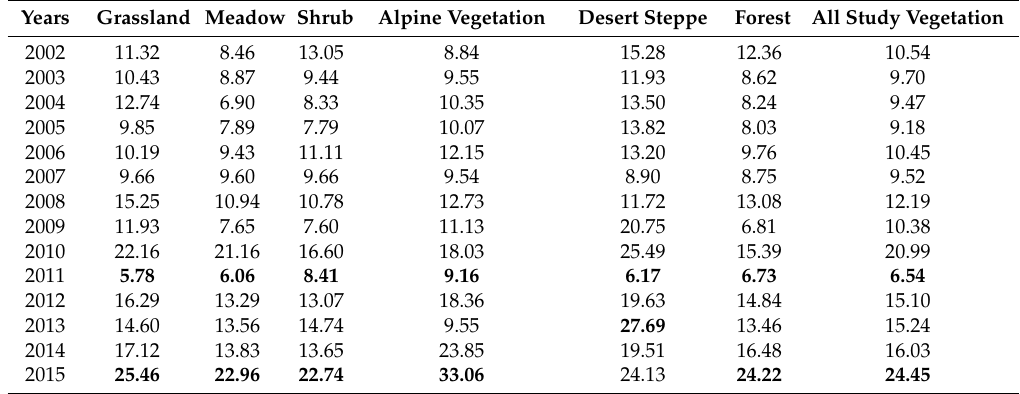
Table 2. Statistical results of the percentage of abrupt change area of different vegetation types for each year between 2000 and 2017. The highest and lowest area percentages of abrupt changes for each vegetation type are shown in